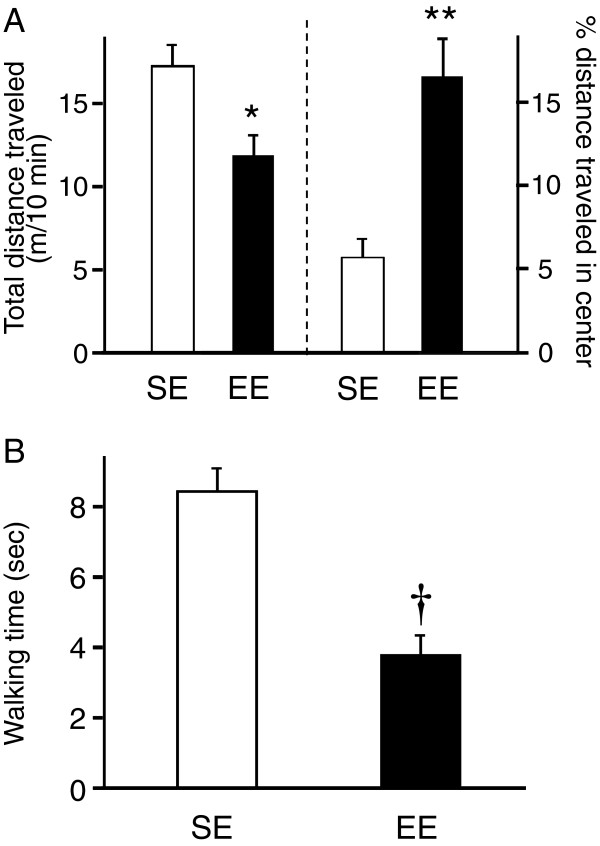
Behavioral assessment in the open field (A) and beam walking (B) tests. In the open field test, the EE rats showed lower locomotive activity in the total distance traveled (A, left) and lowered anxiety reflected in the % distance traveled in the center arena (A, right). In the beam walking test, the EE rats quickly traversed the elevated narrow beam (B). *, **, †, significant difference from SE rats, p < 0.01, 0.005, 0.001, respectively.